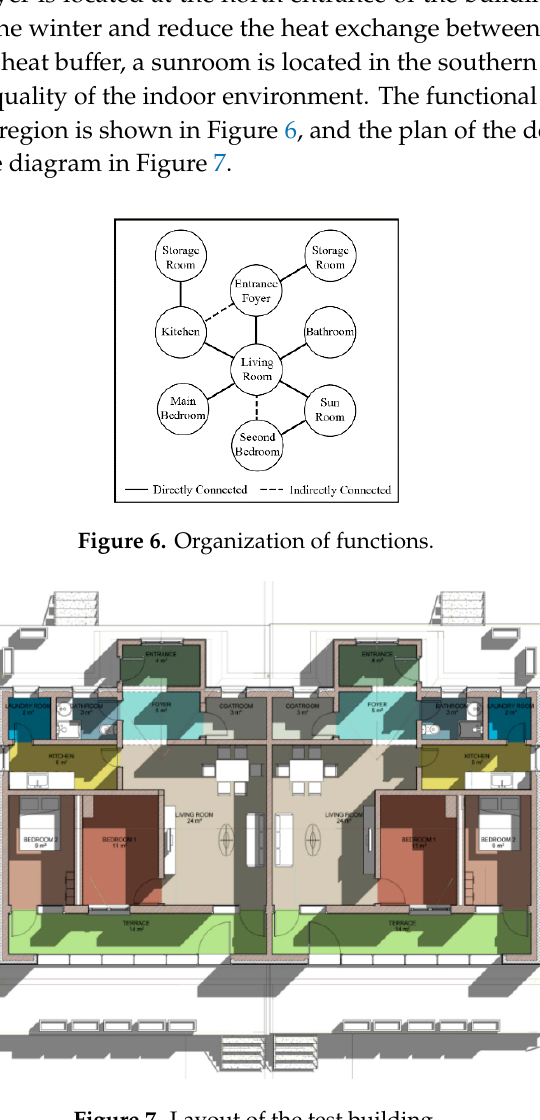
Figure 7. Layout of the test building.